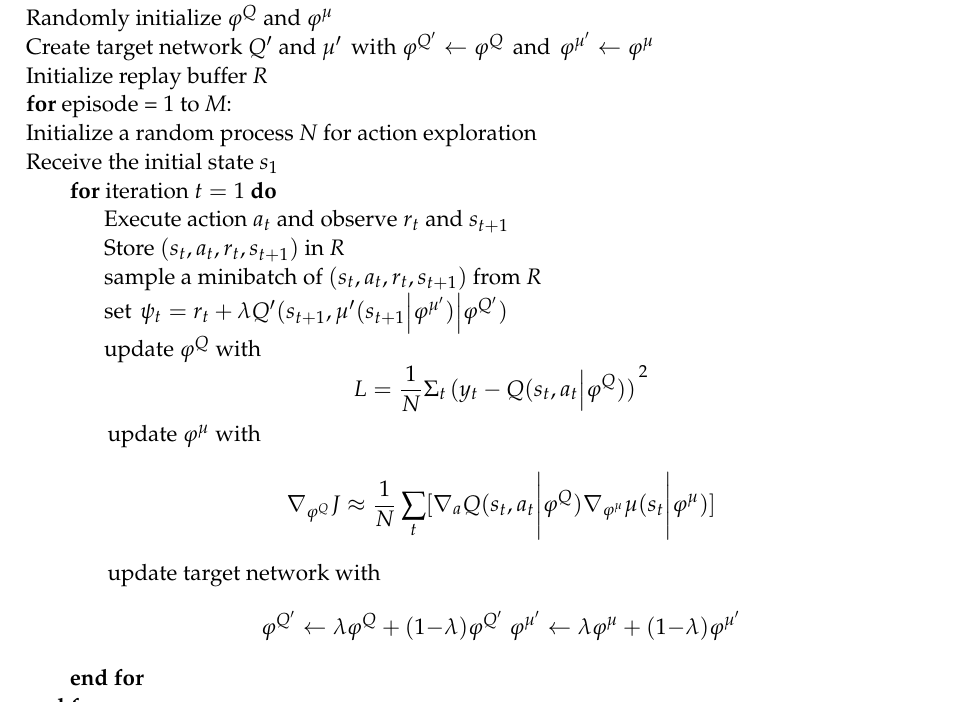
Algorithm 1 DDPG